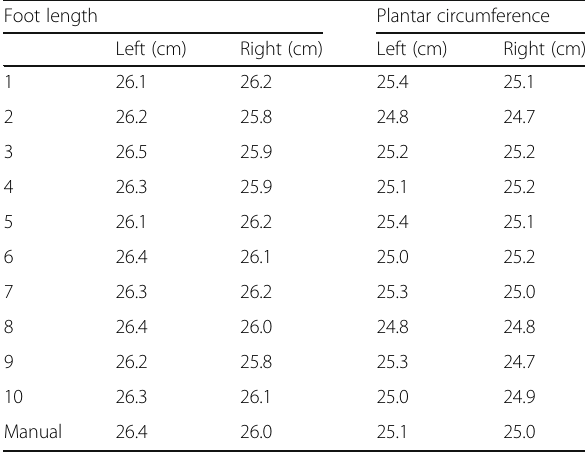
Table 2 Result of multiple measurements of foot length